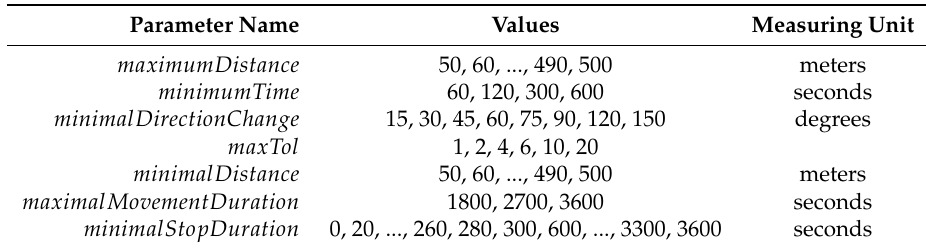
Table 1. Parameter values.